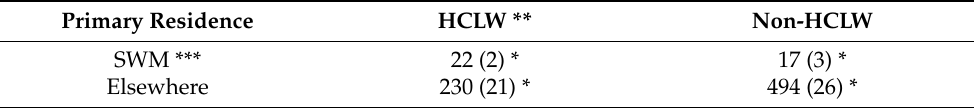
Table 3. Primary residence, week of admission, and mortality in 763 consecutive neurotrauma cases. Primary